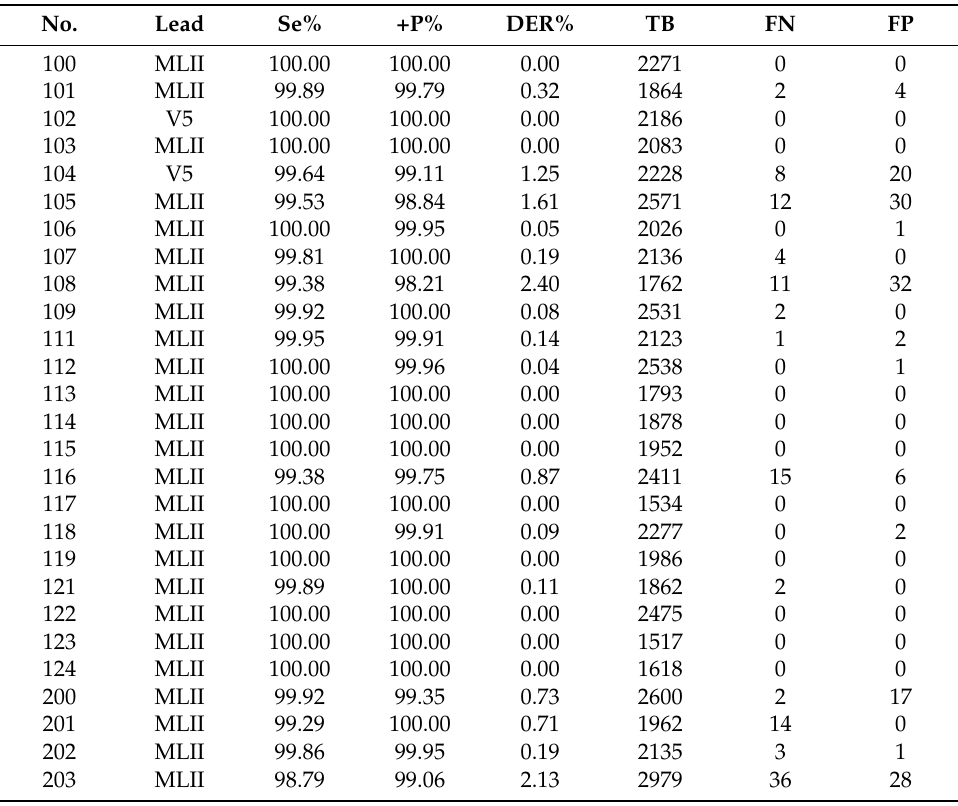
Performance of the proposed method using the single channel of the MIT-BIH arrhythmia